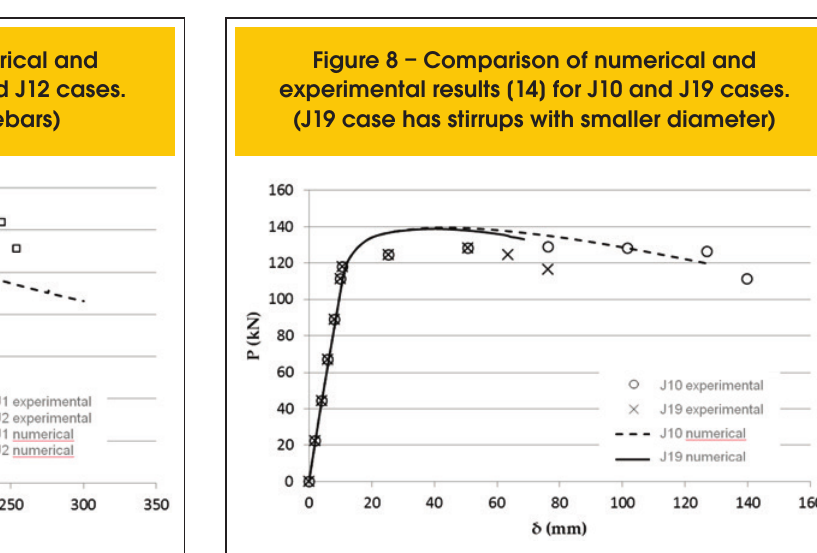
Figure 8 – Comparison of numerical and experimental results [14] for J10 and J19 cases. (J19 case has stirrups with smaller